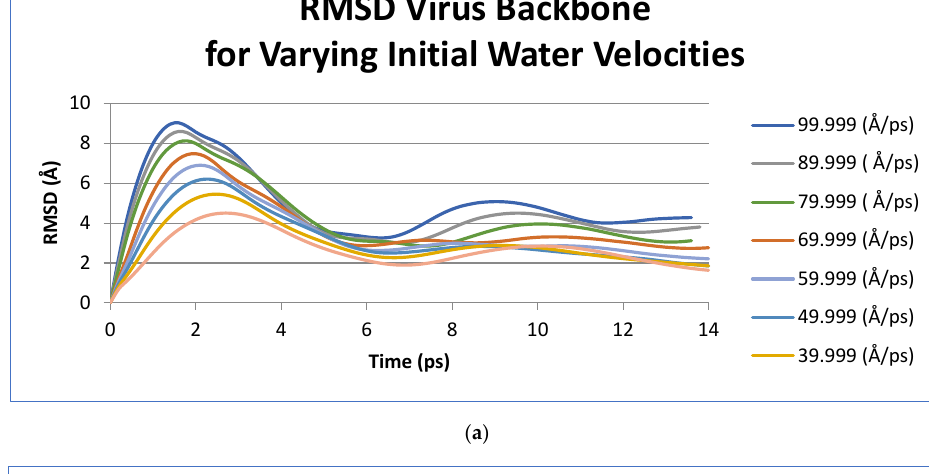
( c ) Figure 2. Output from VMD visualization software for the shockwave with initial water velocities of 99.999 Å /ps showing: ( a ) Illustration of cross-sectional shape of L3 spheroidal mode at maximum deformation (solid line), compared to initial spherical shape (dashed line) ( b ) The virus in its equilibrated state (time = 0.0 ps) — before encountering the shockwave, with spherical cross-section overlaid (dashed line) ( c ) The virus in the maximum compression state (time = 1.4 ps), corre- sponding to the first peak in the RMSD value, with cross-section of L3 mode of a sphere at maxi- mum deformation overlaid (solid line). The color scheme shows the different types of mole- cules — the purple molecules are the nucleic acid of the core while the green molecules are the pro- tein capsid. As seen in Figures 1 and 2, as well as video SV1, when the simulated shockwave front begins to hit the virus at time 200 fs, the structure begins to deform and the mag- nitude of this deformation increases as the wave propagates through the structure and the surrounding water medium, peaking at time 1.4 ps, when the structure is at maxi- mum compression. As the wave reaches the end of the structure, it is stretched out, re-